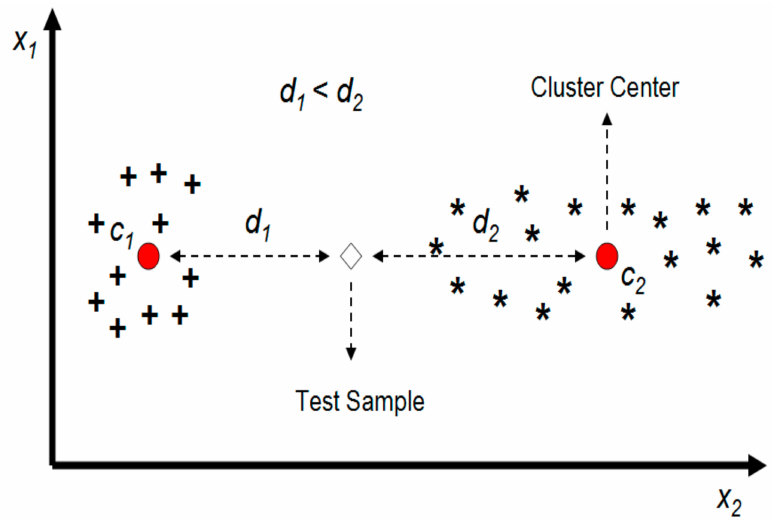
Figure 1. Ine ffi ciency of the distance to cluster’s center measure as a single criterion for choosing the proper